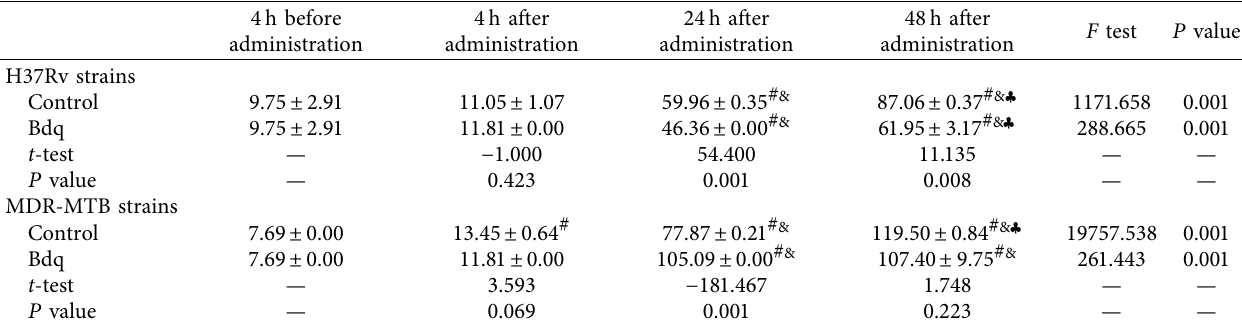
Table 5: Levels of IL-6 in culture supernatants of macrophages infected with H37Rv and MDR-MTB strains after Bdq administration (pg/ ml, x ± s